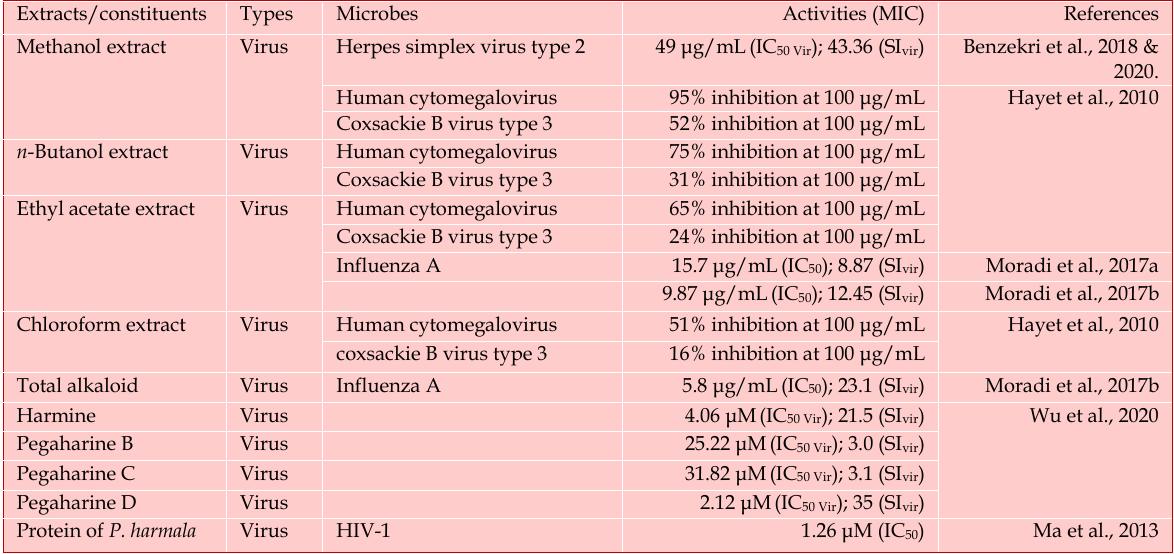
Antimicrobial activities of Peganum harmala